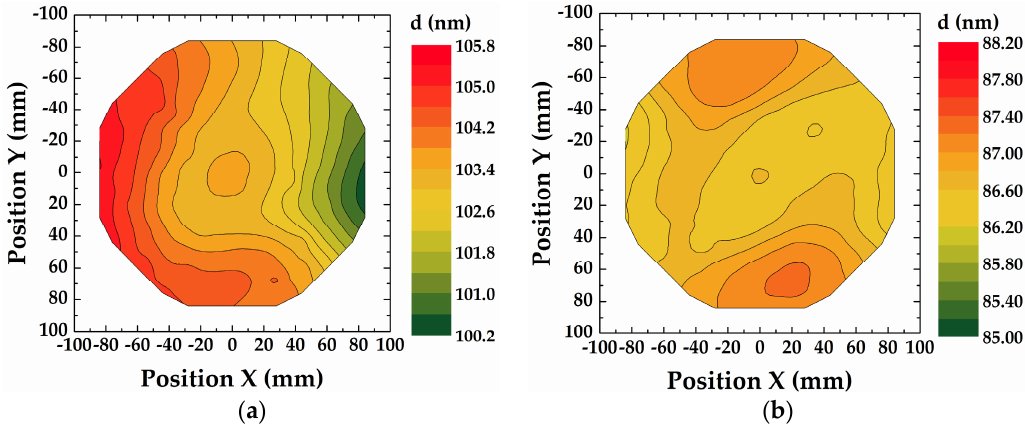
Figure 2. Thickness uniformity mapping of Al 2 O 3 (thermal ALD) on a 200 mm wafer measured after ( a ) 1156 ALD cycles without rotation, ( b ) 1000 ALD cycles with manual sample rotation by 180° after 500 ALD cycles.